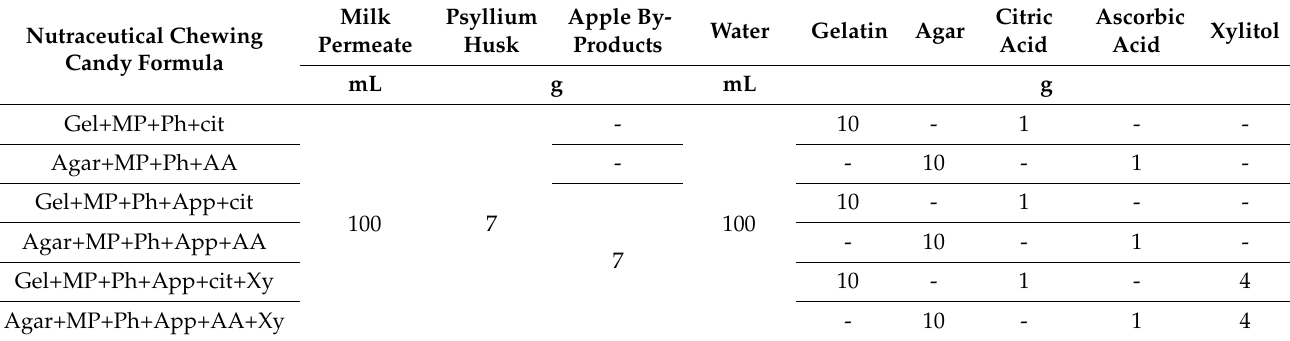
Table 1. Nutraceutical chewing candy (CCN) formulas.